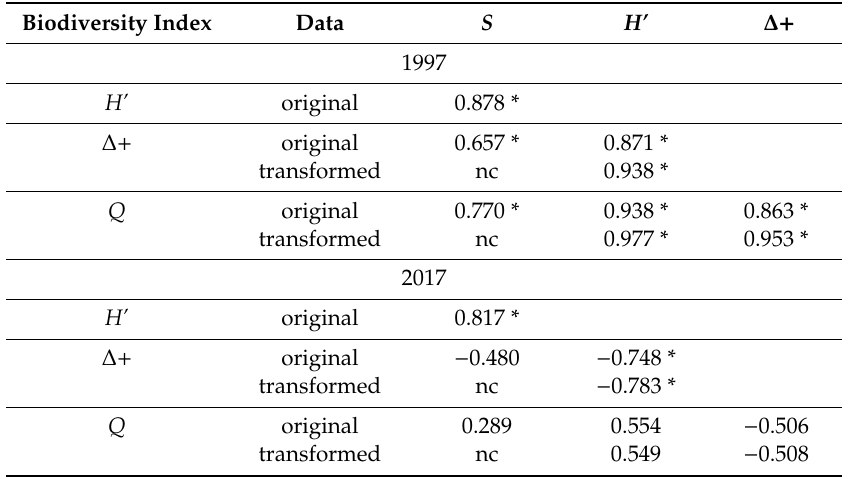
Table 7. Relationship between weed biodiversity indicators (original or transformed data respectively) showed in simple correlation coe ffi cients.